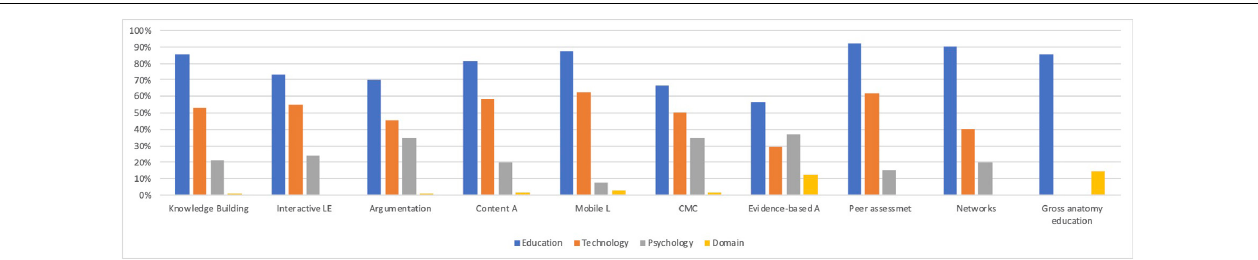
FIGURE 2 | Disciplinary composition of the publishing journals by